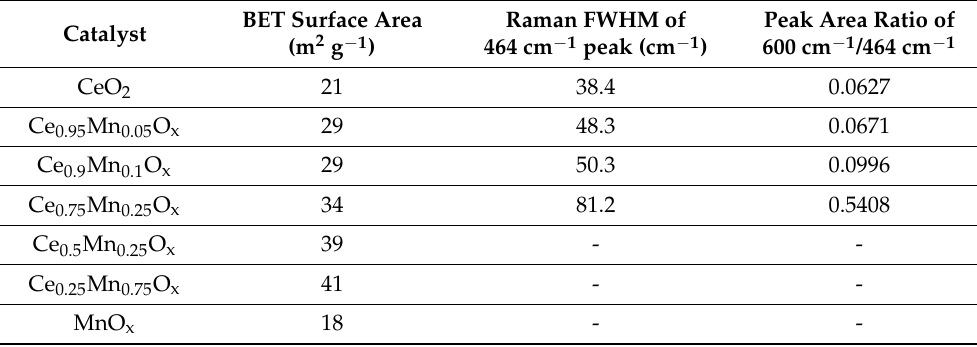
Table 2. Brunauer–Emmett–Teller (BET) Surface area and Raman characteristics of sodium carbonate co-precipitated ceria-manganese mixed metal oxide catalysts. FWHM = full width half maximum. BET Surface Catalyst